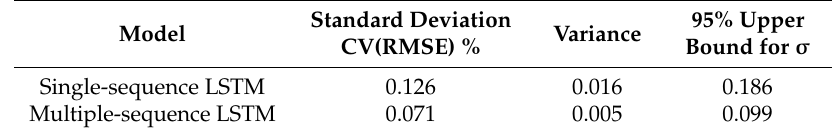
Table 6. Statistics for single and multiple-sequence models on various forecasting horizons.